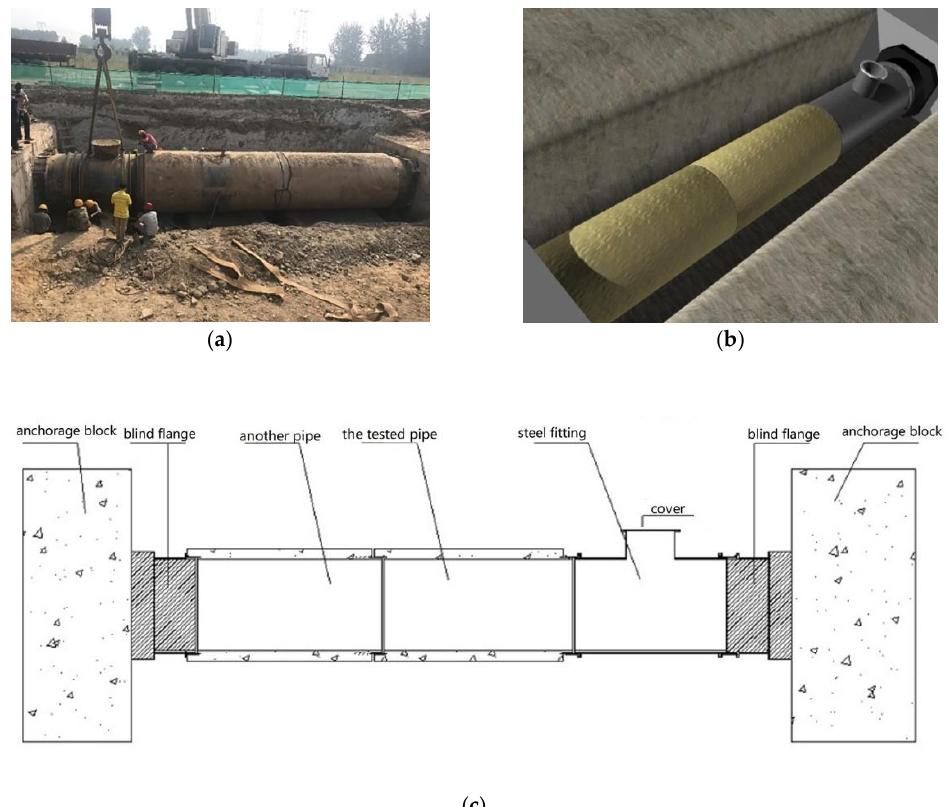
Figure 5. The schematic diagram of the test apparatus: ( a ) a spot photo; ( b ) design sketch in 3D; ( c ) design sketch in 2D.